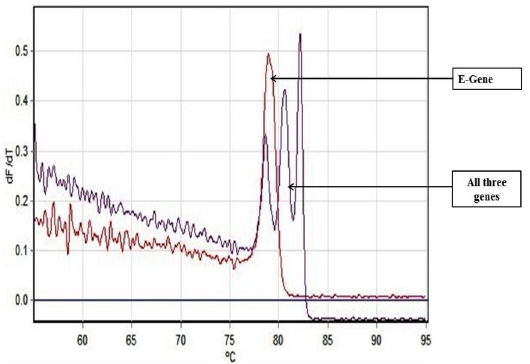
Figure 9. Individual melt curve peak for E gene obtained upon single-plex RT-PCR reaction using primer pairs for E gene.